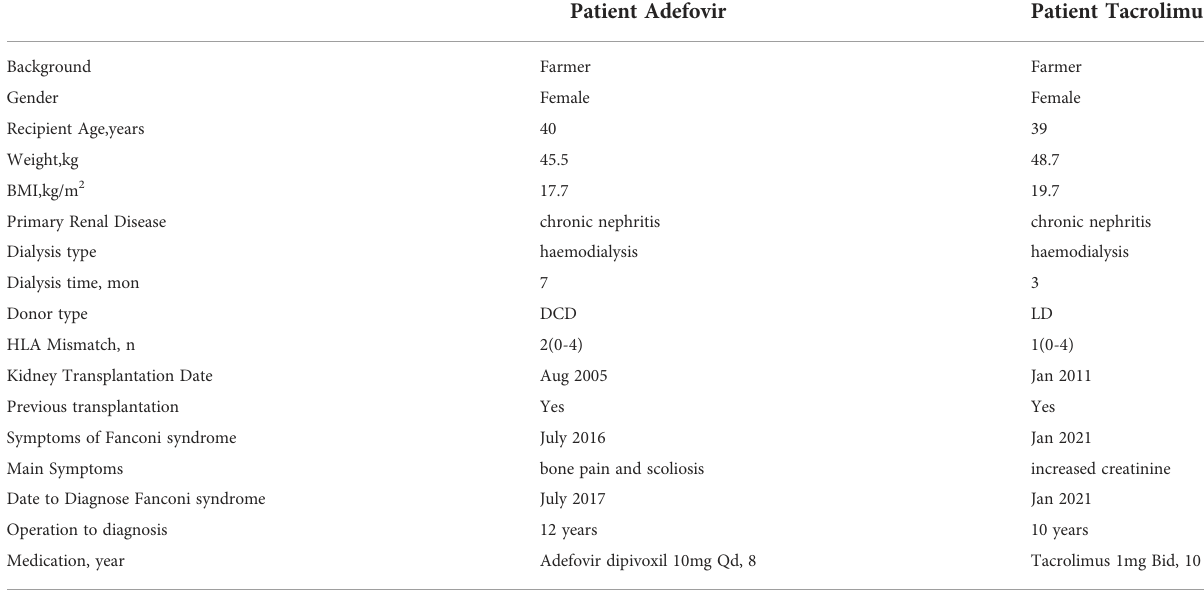
TABLE 1 Demographic and